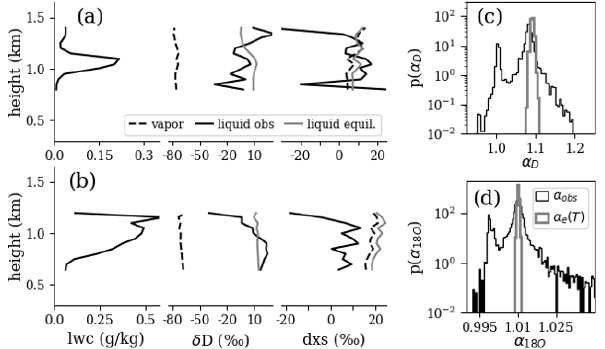
Figure 12. (a, b) Examples of individual vertical profiles for LWC and isotope ratios of vapor and cloud liquid. Profiles predicted by equilibrium fractionation using temperature measurements are in- cluded. (c, d) Probability distributions of observed fractionation fac- tors, defined as in Eq. (2), for all profile data below 4km (taken roughly as the freezing level), and equilibrium fractionation factors computed from